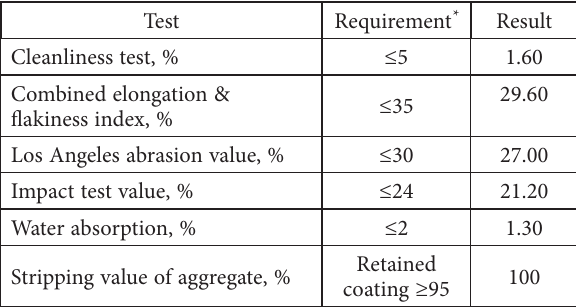
Table 1. Physical properties of aggregates